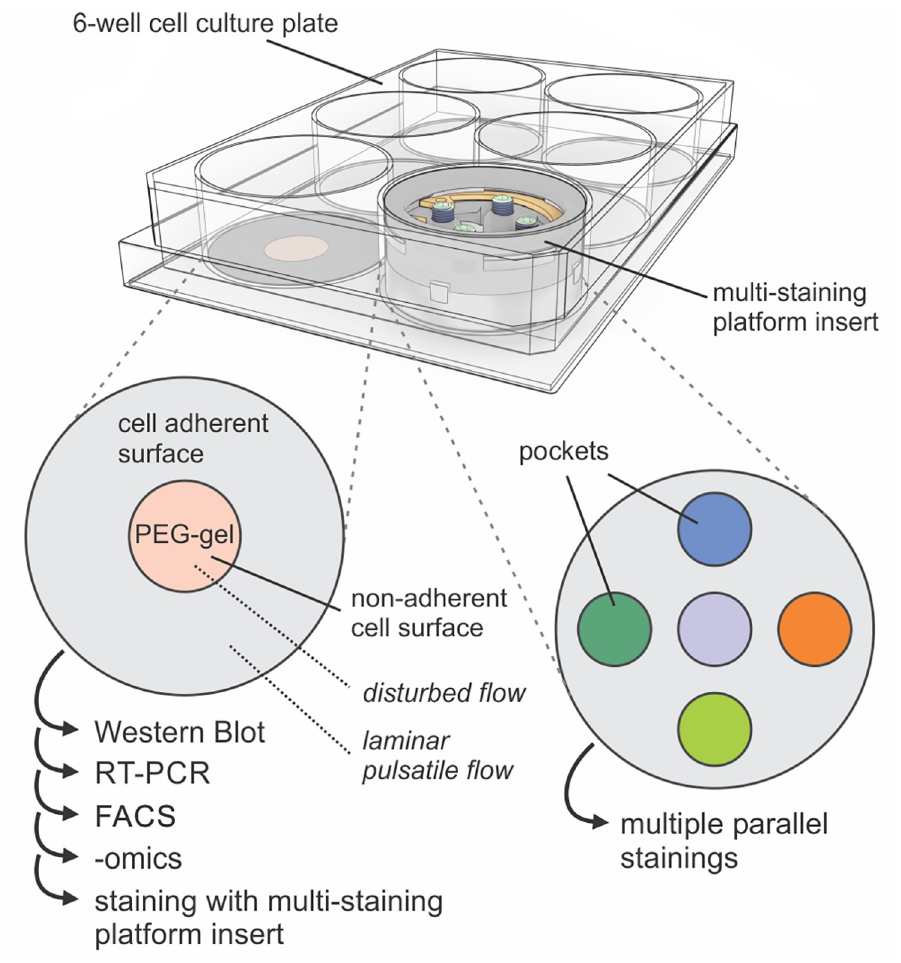
Fig 1. Overview of a 6-well plate and the proposed solutions. Left: Non-adherent PEG coated surface in the central region of the well, where flow is disturbed. This solution allows to selectively grow cells in the periphery where flow is physiological (laminar pulsatile). After cell culture, a more homogeneous sample can be harvested for various biochemical assays (Western blot, RT-PCR, FACs, -omics) or stained using our second solution, shown on the right. Right: Multi-staining platform insert, which can be applied after sample fixation. Five individual pockets, one in the center and four in the periphery, allow up to 16 parallel stainings, considering four stainings per pocket and a comparison between a peripheral pocket and the one in the